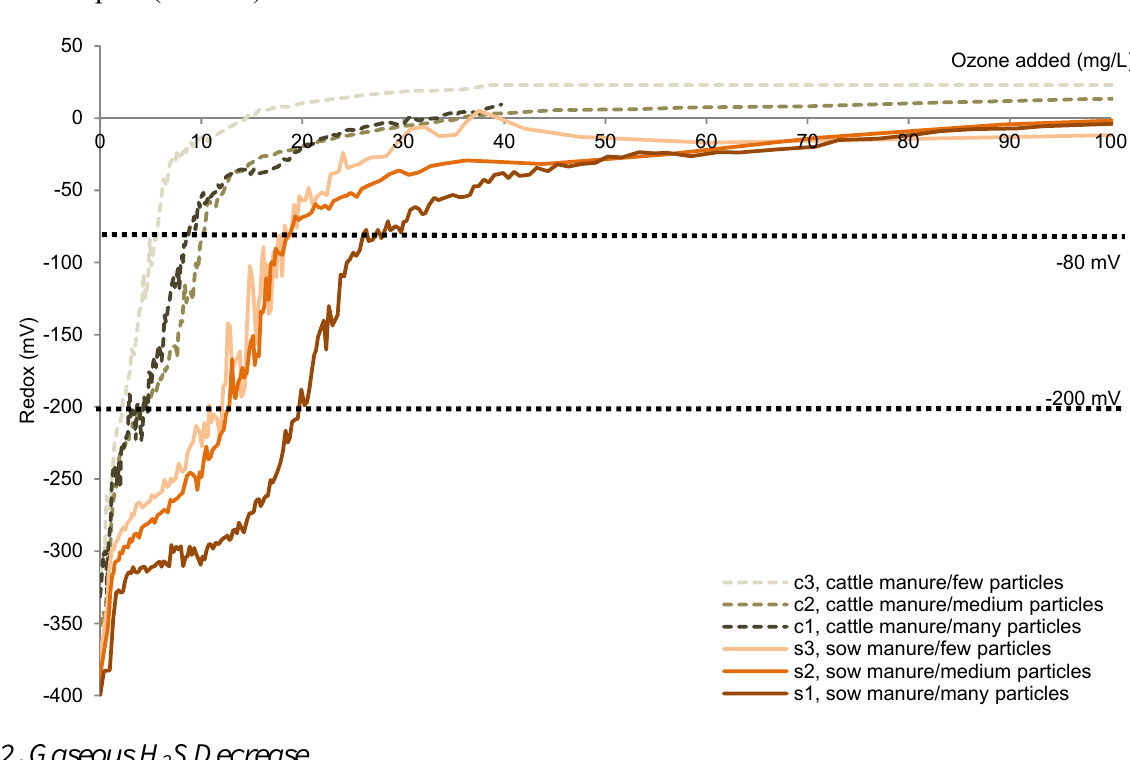
Figure 2. Oxidation curves upon addition of ozone enriched oxygen of the six manure samples ( n =